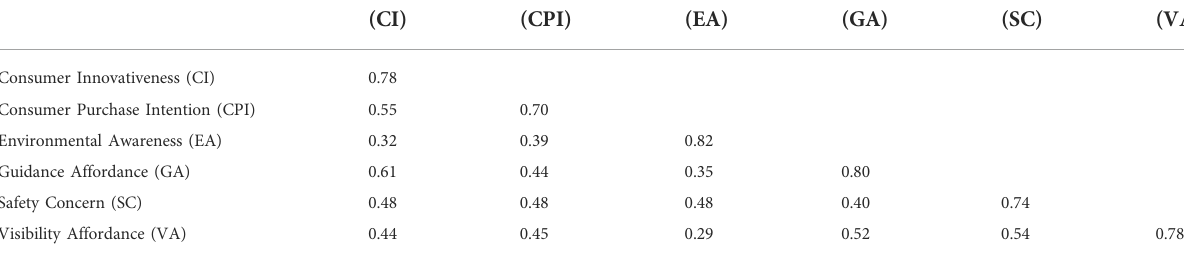
TABLE 4 Discriminant validity through heterotrait-monotrait ratio (HTMT).